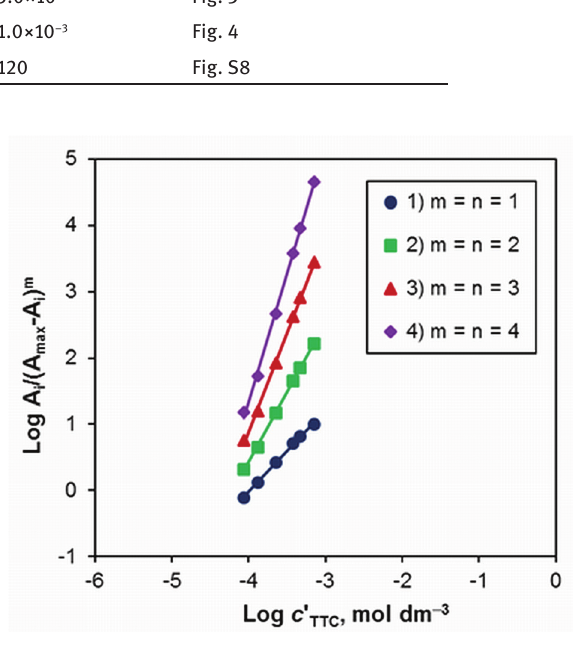
Figure 6: Determination of the TTC:V IV molar ratio by the mobile equilibrium method for λ = 333 nm and m = n. pH 5.5, c